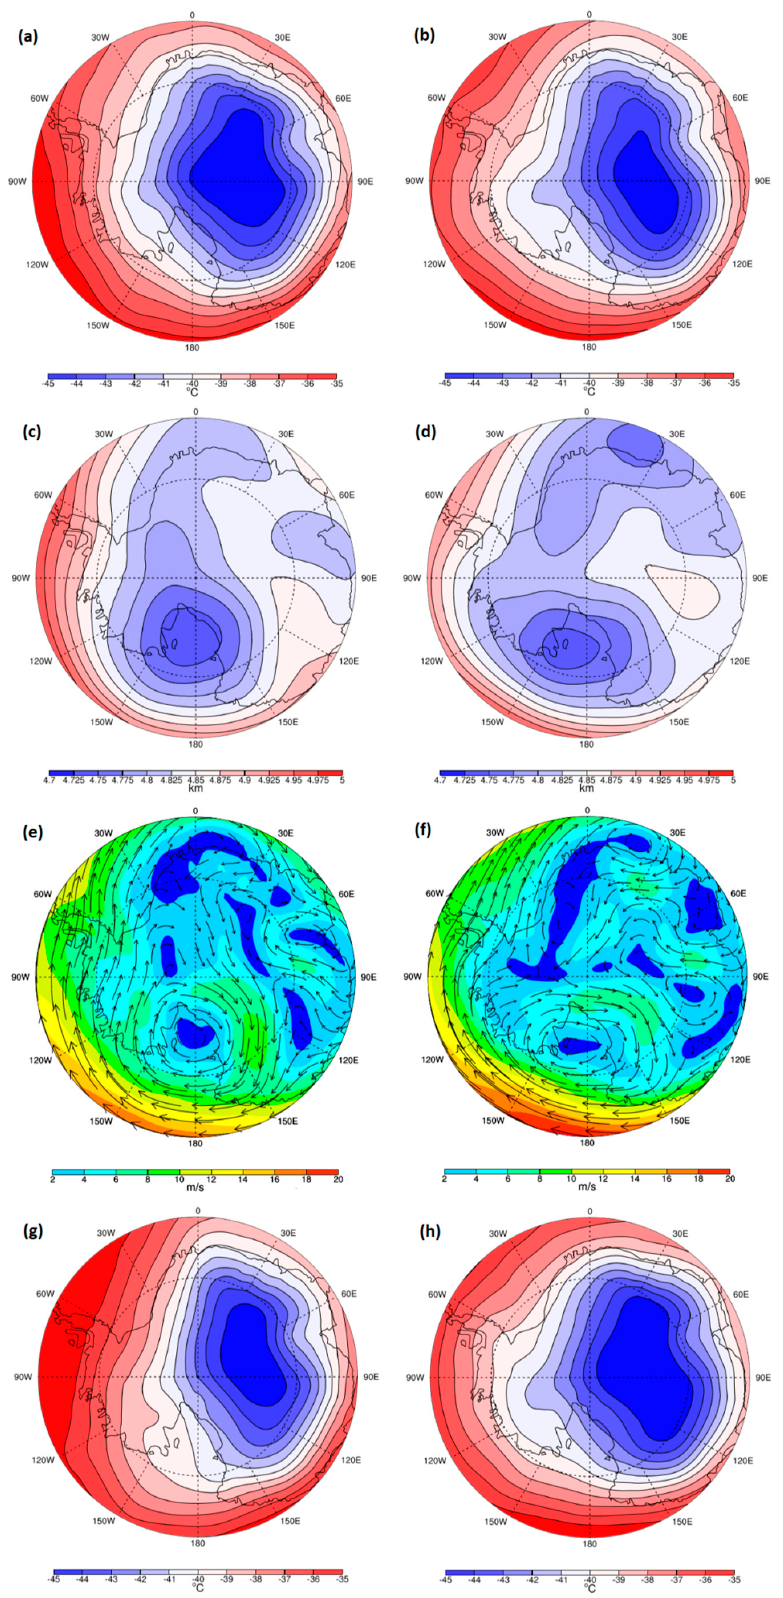
Figure 6. The spatial pattern of temperature in ( a , b ) August and ( g , h ) September, and geopotential ( c , d ) height and ( e , f ) winds in August at 500 hPa during 2005 – 2008 (left panels) and 2015 – 2018 (right panels).